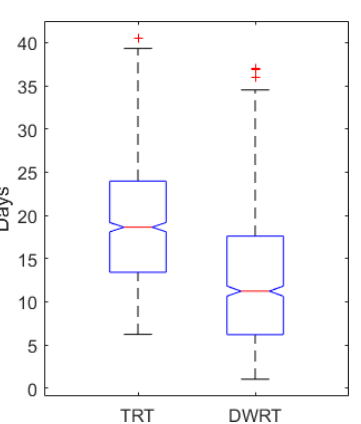
Figure 17. Box–whisker statistics of total (TRT) and dense-water (DWRT) residence times for the coastal northeastern Adriatic bor- dered by transects T1, T2, T3, T4 and